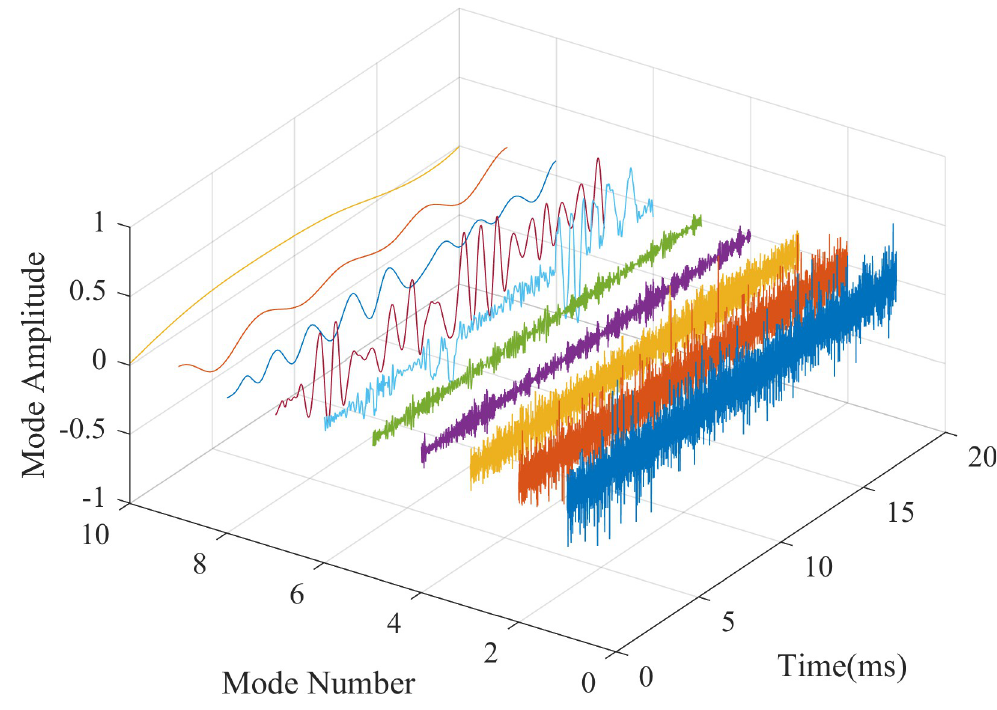
Fig 6. Comparison of IMFs and residual of REMD.